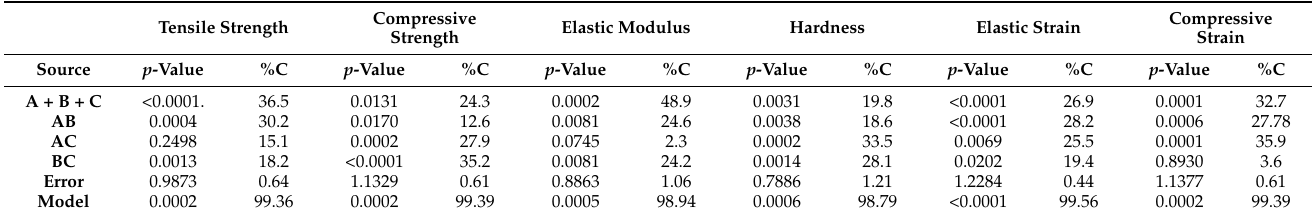
Table 2. The p -values of the responses.